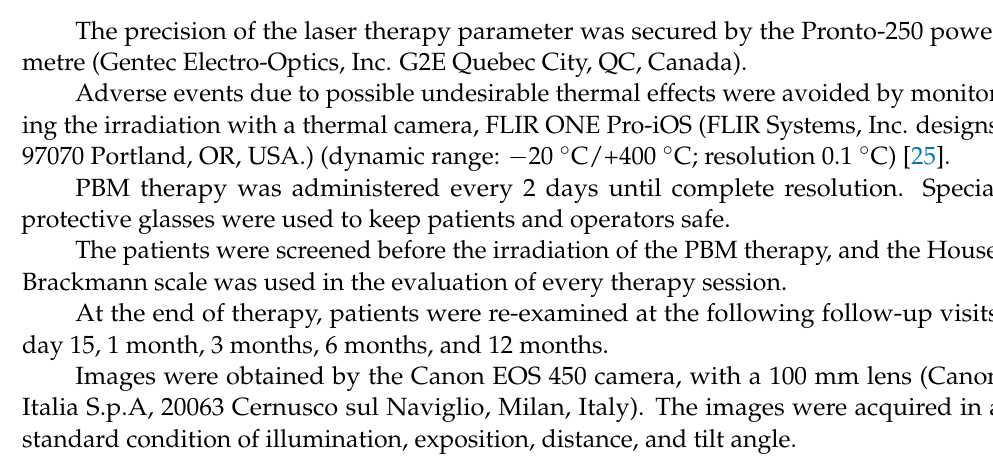
Figure 3. Laser parameters and treatments session design. The laser therapy was irradiated through a flat-top beam profile hand-piece, every 2 days until complete resolution. Previously, we showed [25] the flat-top hand-piece * is able to maintain constant power and beam spot size from contact to many centimeters away allowing for improved clinical consistency during PBM treatments delivery. ** BP resolution was experienced after different treatment sessions, from 8 up to 18. Image created with BioRender.com.